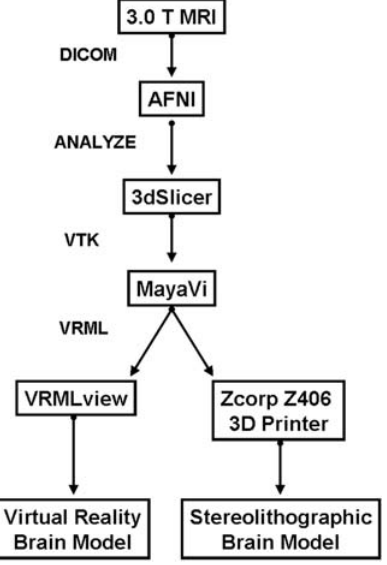
Figure 1. MRI-based Reverse Engineering Processing Pathway. Freely available software and file formats used to produce virtual and stereolithograph brain models are diagrammed. AFNI is available from [http://afni.nimh.nih.gov/]; 3dSlicer is available from [http://www.slicer .org/]; MayaVi is available from [http://mayavi.sourceforge.net/].